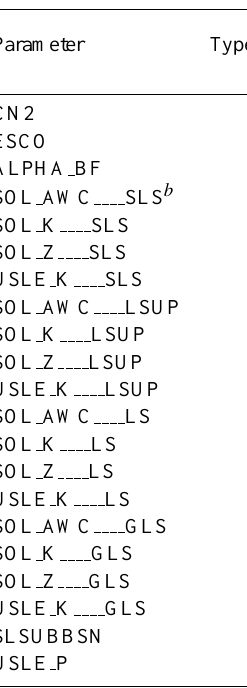
Table 2. Results of parameters calibration.